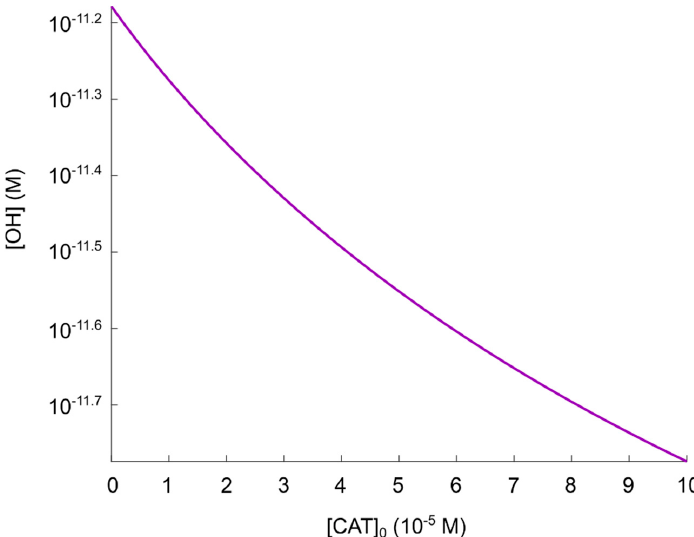
Figure 8. Maximal concentration of hydroxyl radicals as a function of catalase concentration in the regime 0 ≤ [𝐶𝐴𝑇] (cid:2868) ≤ 10 (cid:2879)(cid:2872) M .